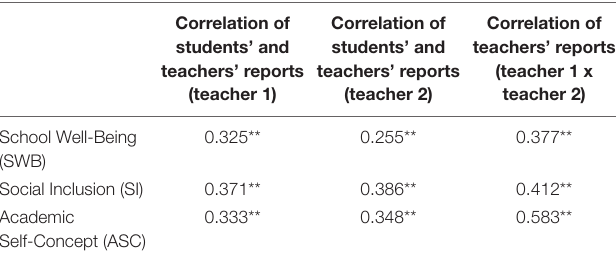
TABLE 3 | Correlations of students’ and teachers’ reports (trait